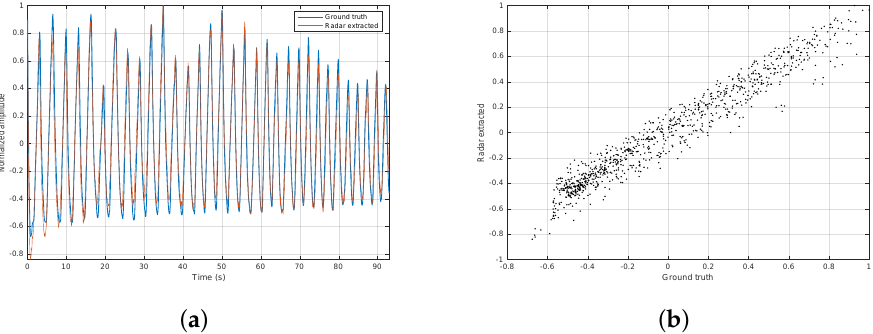
Figure 9. Experiment 3 signal extraction. ( a ) ground truth and radar extracted on top of each other. ( b ) correlation